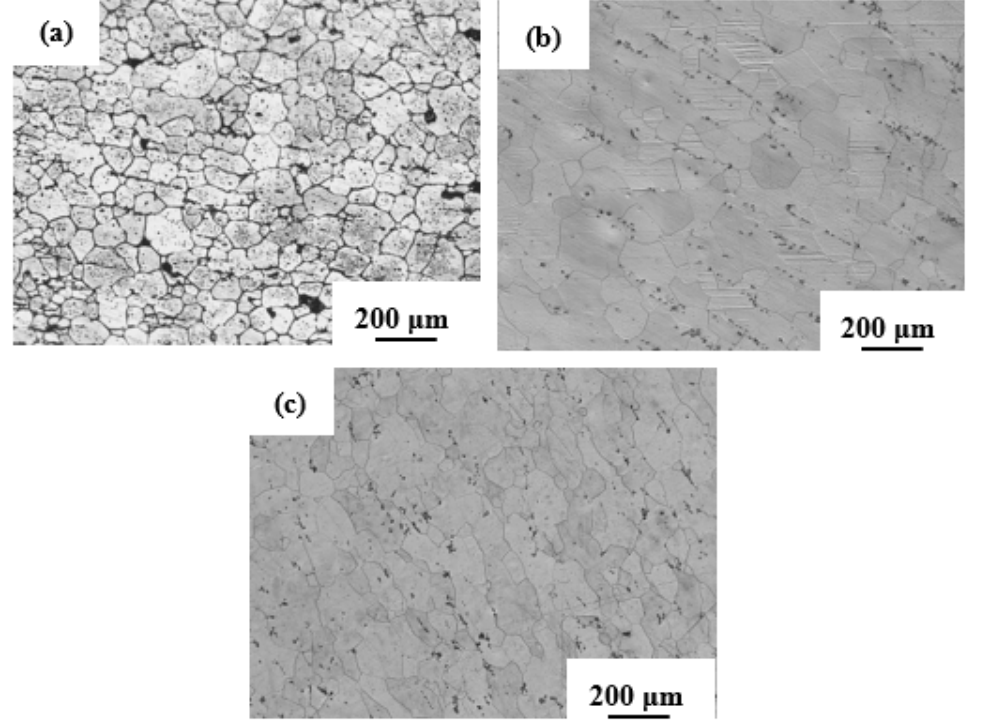
Figure 4. The optical microstructures of the extruded Al-Zn-Mg-Cu-based alloy annealed under ( a ) atmospheric pressure, ( b ) 2 GPa, and ( c ) 3 GPa,